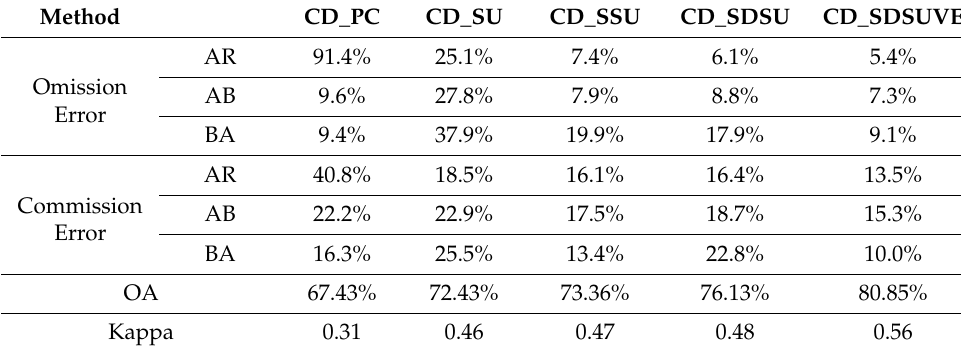
Figure 12. The change detection results of real data 2: ( a ) reference image, ( b ) CD_PC, ( c ) CD_SU, ( d ) CD_SSU, ( e ) CD_SDSU and ( f ) CD_SDSUVE. Table 7. The accuracy statistics for real data 2.